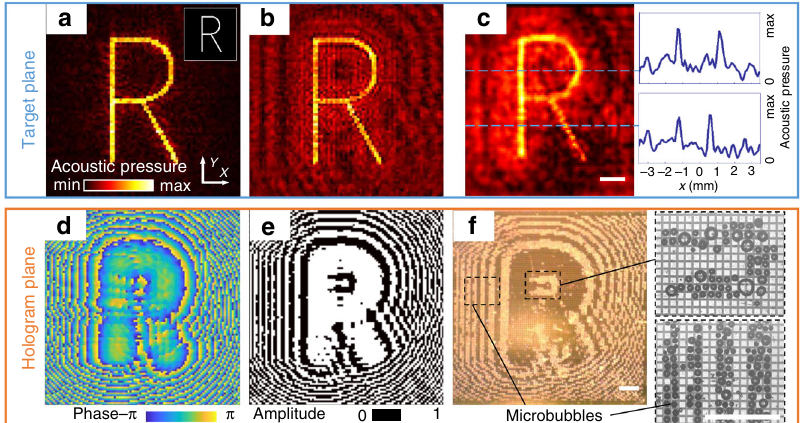
Fig. 4 Performance of the 10,000-element spatial ultrasound modulator. Calculation of the phase hologram for the target image ( a ) and the corresponding phase front in the plane of the hologram ( d ). Calculations are based on the iterative angular spectrum method, and the phase distribution at the hologram plane is modi fi ed upon the back-propagation from the target acoustic amplitude fi eld (top right inset). Comparison of the same target in a binary amplitude hologram ( b , e ). The experimental result showing the hydrophone scan ( c ) of the acoustic fi eld in the target plane, which is generated by the bubble array in the hologram plane of the SUM ( f ). All scale bars are 1 mm.